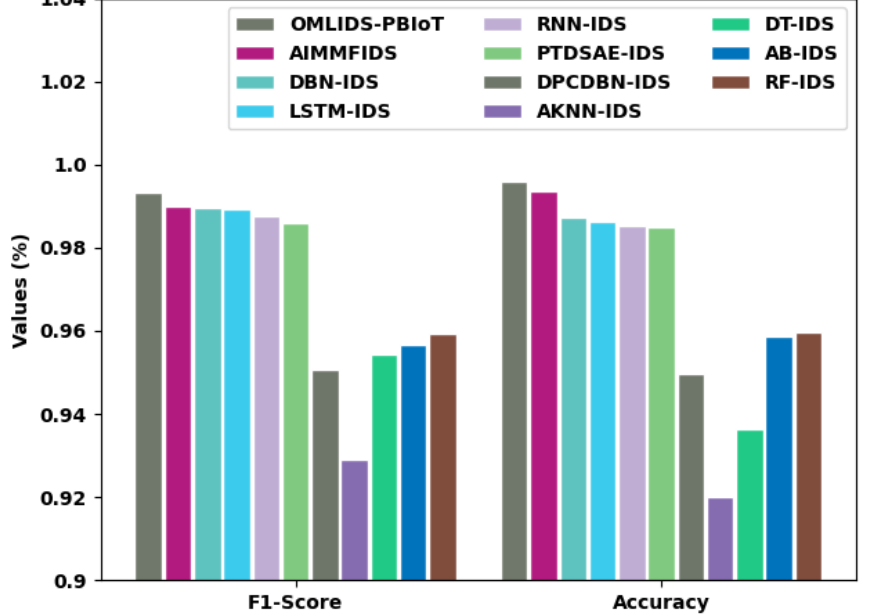
Figure 10. F 1 score and accu y analysis of OMLIDS-PBIoT technique with existing Figure 10. 𝐹1 𝑠𝑐𝑜𝑟𝑒 and 𝑎𝑐𝑐𝑢 𝑦 analysis of OMLIDS-PBIoT technique with existing ap- proaches.